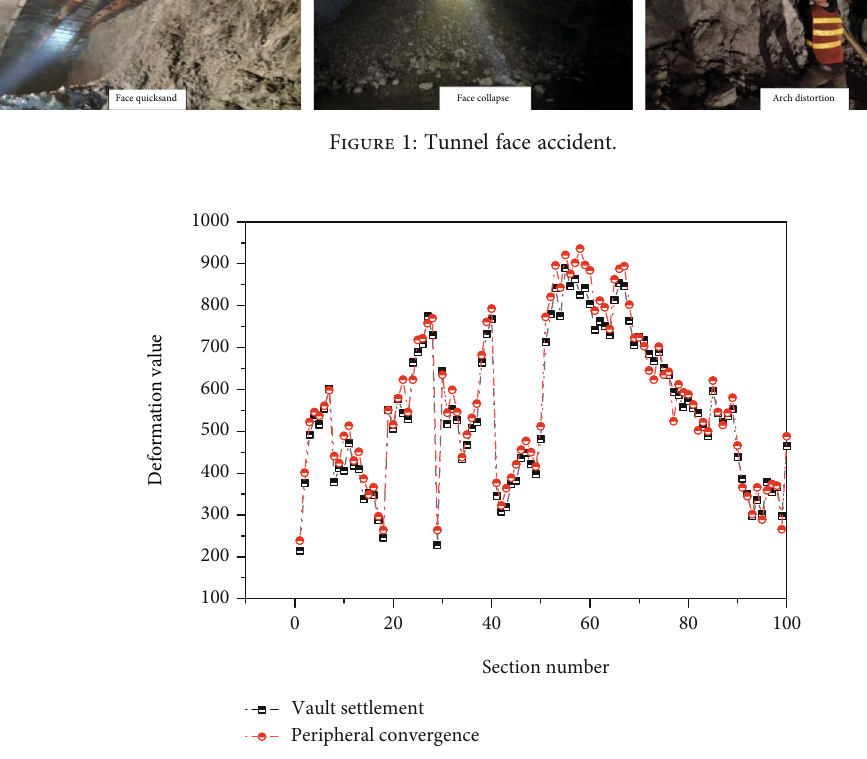
Figure 2: Tunnel deformation